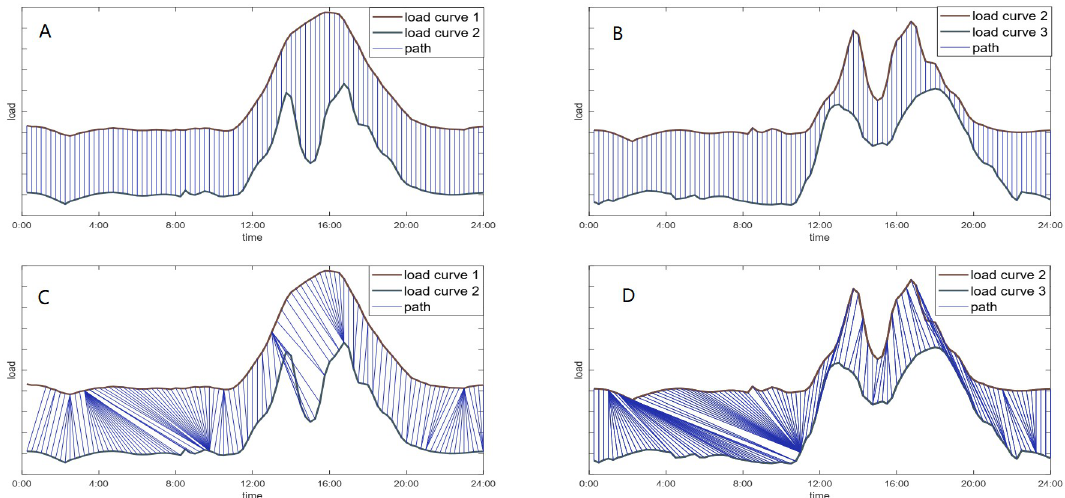
Fig 1. The comparison between Euclidean distance and DTW distance. (A) and (B) show the alignment rule of Euclidean. Ignoring the time shifts, the distance between the unimodal curve (load curve 1) and the unimodal curve (load curve 2), d EU ( curve 1, curve 2) = 4.2742, is smaller than the distance between the unimodal curves (load curve 2 and load curve 3) d EU ( curve 2, curve 3) = 4.8454. (C) and (D) on the contrary, show the alignment rules of DTW. Considering the time shifts, the distance between the unimodal curve (load curve 1) and the unimodal curve (curve 2), d DTW ( curve 1, curve 2) = 0.0299, is larger than the distance between the unimodal curves (load curve 2 and load curve 3) d DTW ( curve 2, curve 3) = 0.0099. Notes: in order to show the alignment clearly, we move down the lower curve for 2